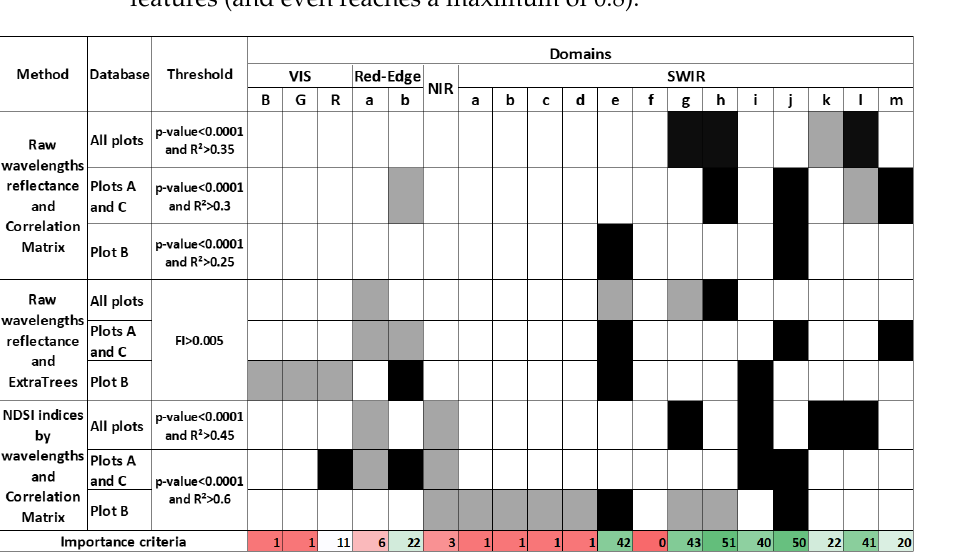
Figure 18. Summary of the three previous sections’ results for the three methods either with the data of all plots, for plots A and C, or for plot B. The darker the cell, the greater the significance of the domain: black cell for an importance score of 10 (best R 2 or FI), gray cell for an importance score of 1 (significant p -value but lower R 2 or FI), and white cell for a score of 0 (result not significant). When the spectral domain is emphasized for all plots, the score is doubled. The sum of the scores for each domain is recorded at the bottom of the table and is called the “Importance